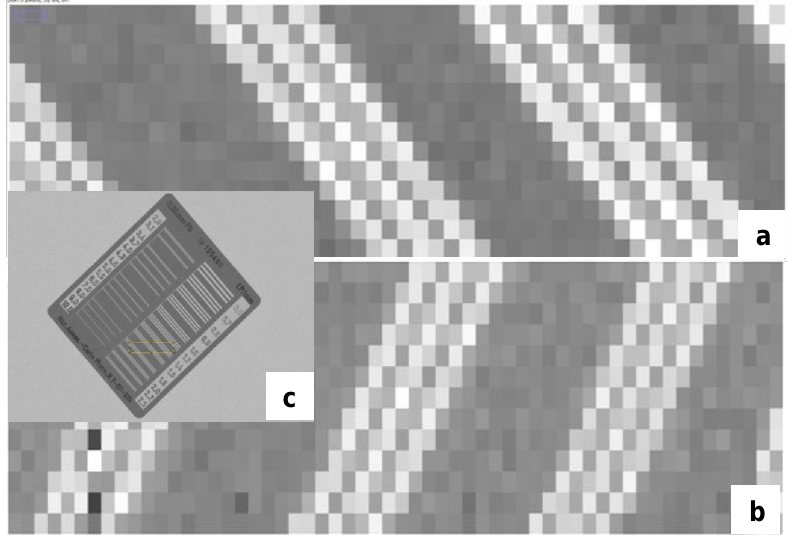
Figure 19. X-ray resolution image test from (a) a commercial FPD14 PPS array at 1.6 lp/mm shown in center of image (b) prototype 64 × 64 APS array at 2.0 lp/mm shown in center of image and (c) the resolution